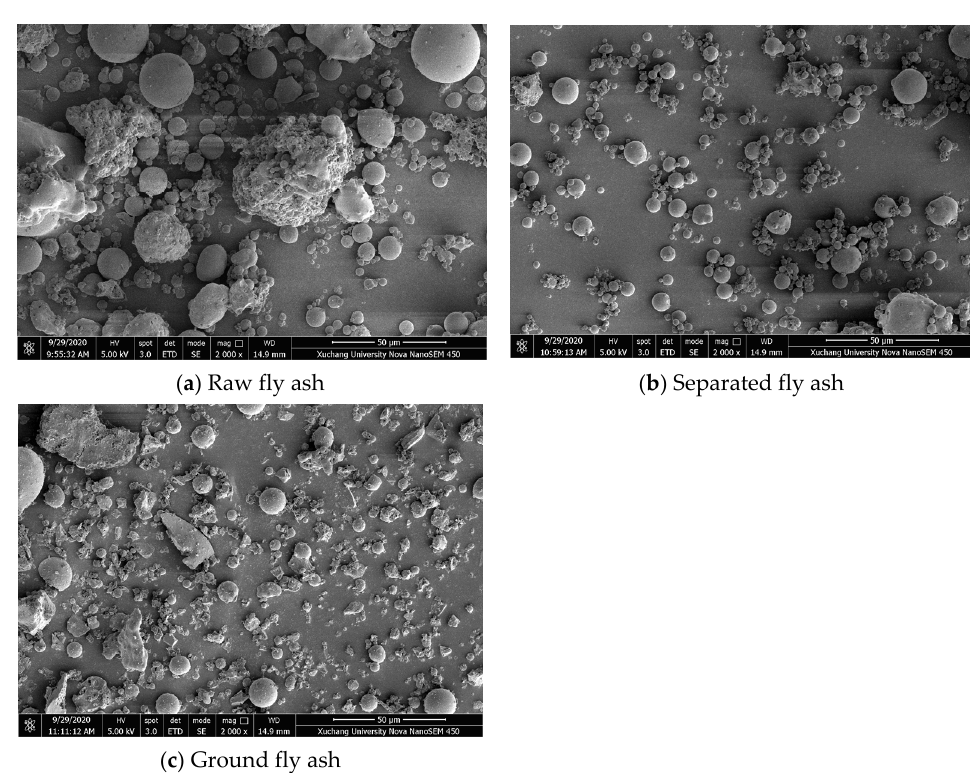
Figure 2. Morphology SEM-BSE images of different fly ash.